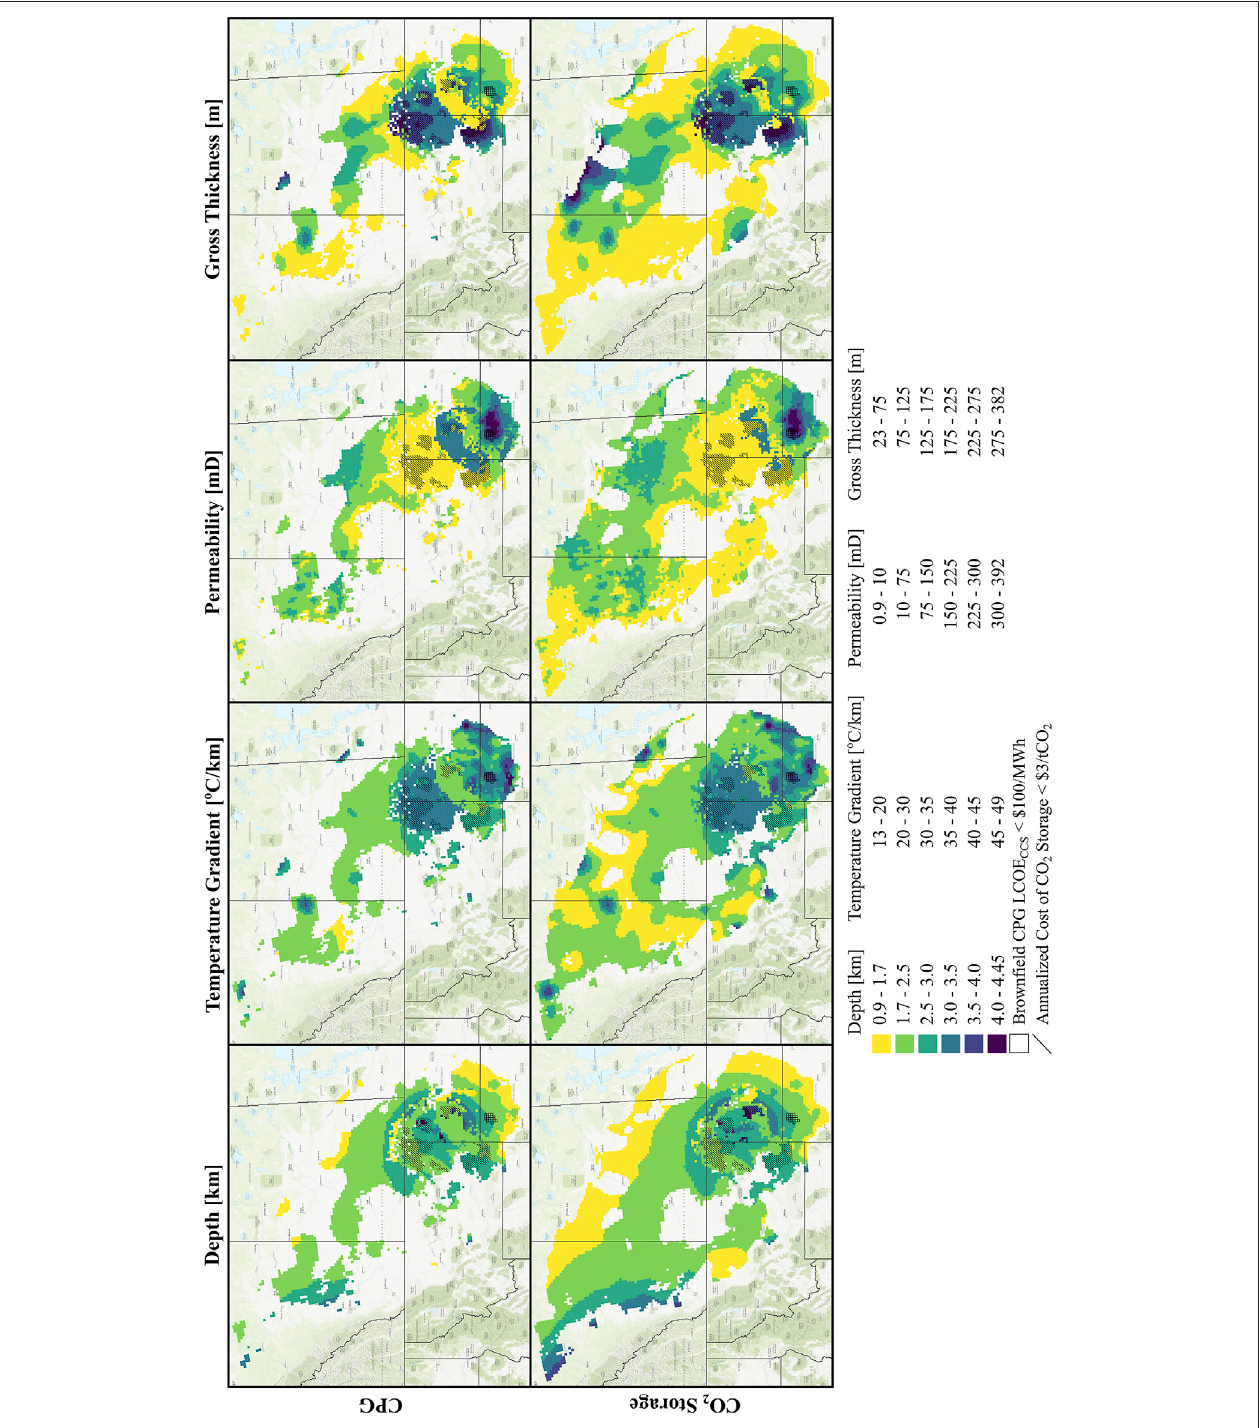
FIGURE 3 | Geologic Conditions That Yield the Lowest Cost When the Net-to-Gross Ratio is 60%. For CPG (top row of maps), the geology of grid cells with low power generation (black area in Figure 2 ) are not plotted.